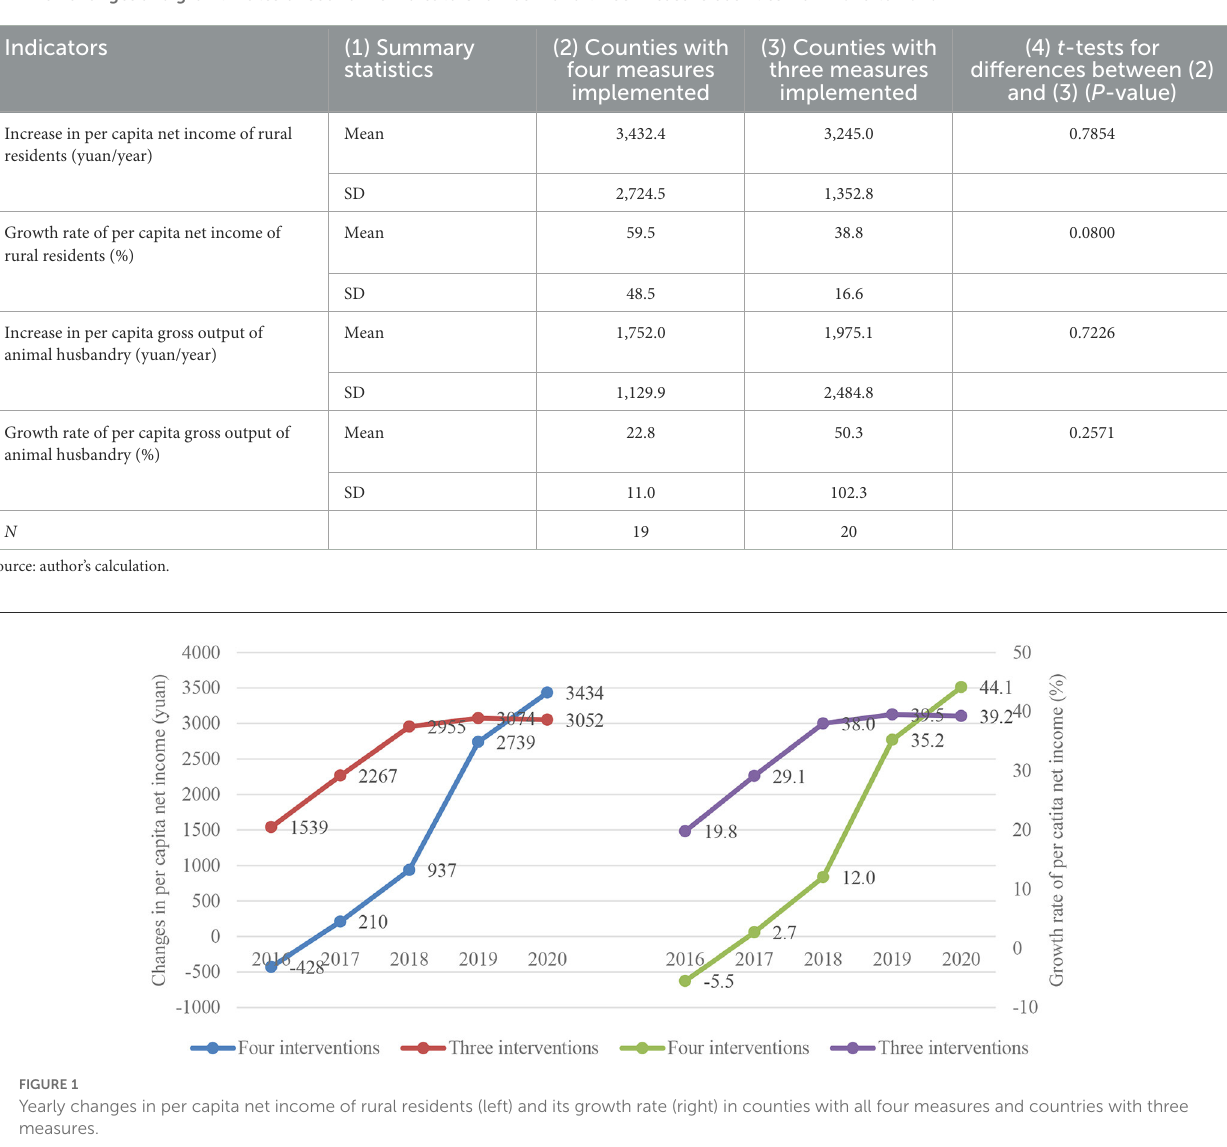
implemented during the evaluation period over those with only three measures